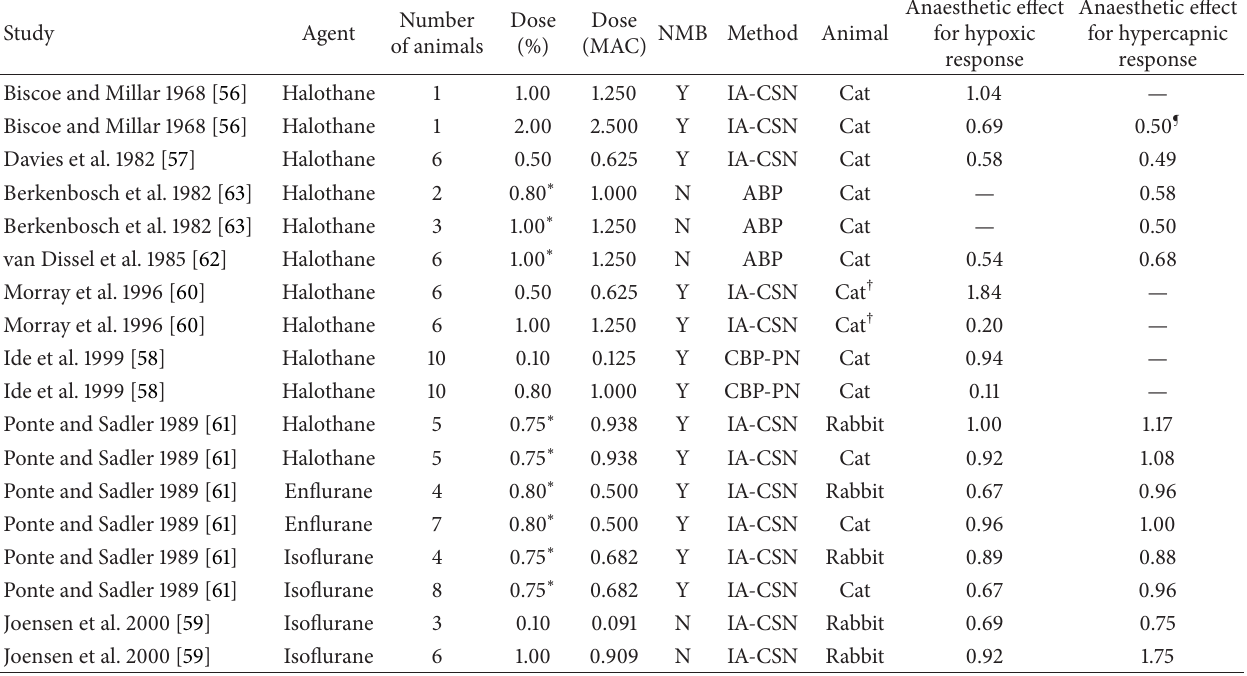
Table 1: Summary of studies examining effect of volatile anaesthetics on carotid body responses.